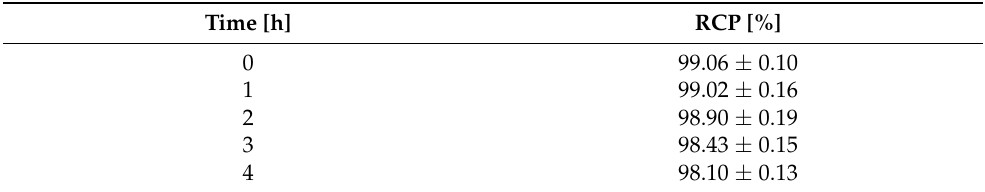
Figure 2. Reversed-phase high-performance liquid chromatography (RP-HPLC) chromatograms of the ( A ) unlabeled precursor Glu-NH-CO-NH-Lys(Ahx)-HBED-CC (PSMA-11), ( B ) [ 68 Ga]GaCl 3 , and ( C ) [ 68 Ga]Ga-PSMA-11. Table 2. Stability of [ 68 Ga]Ga-PSMA-11 in saline solution at room temperature, assessed with RP-HPLC